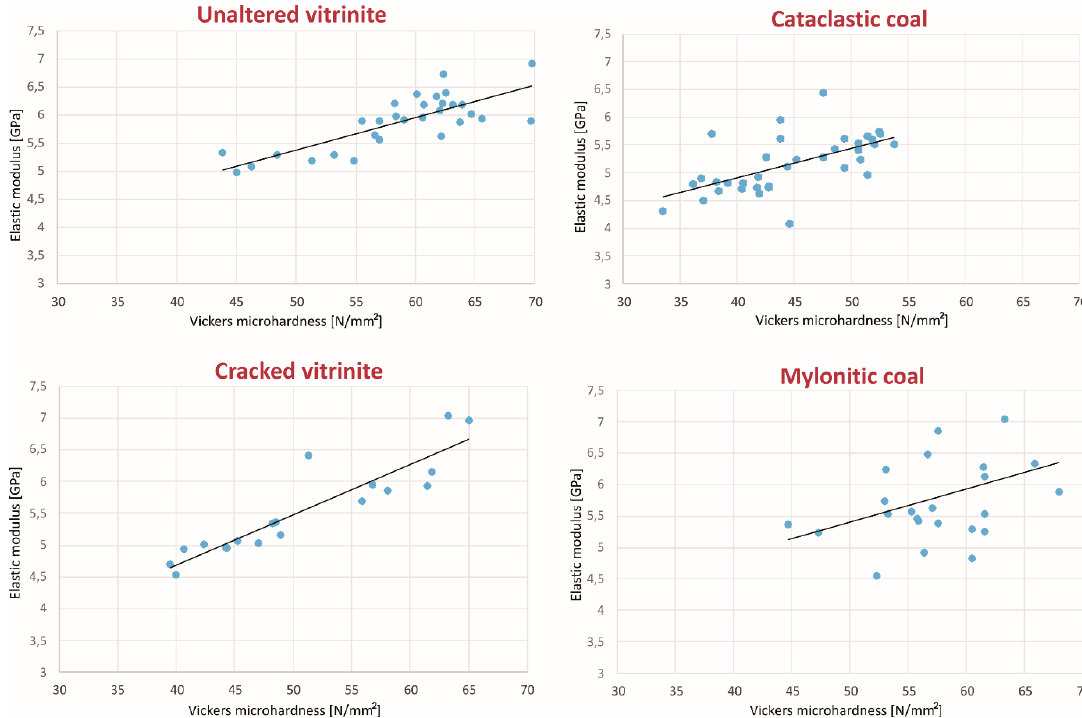
Figure 7. Relationship between the Vickers microhardness and the elasticity module for particular structural types of coal.